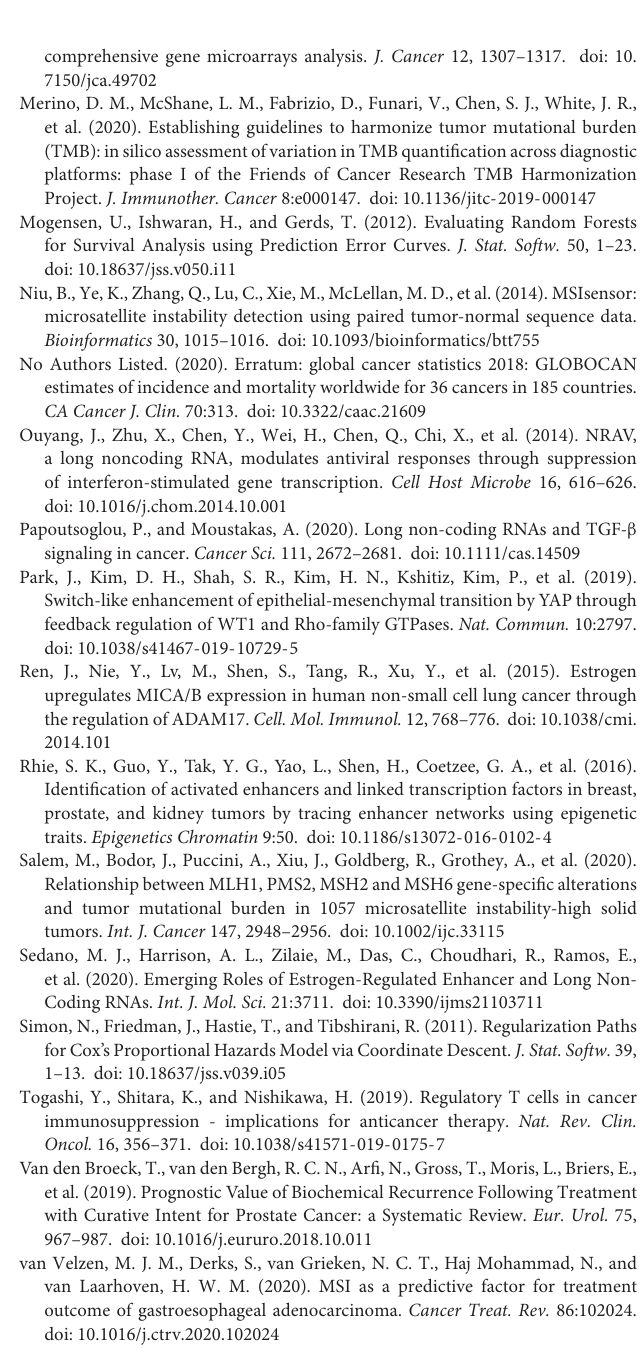
Supplementary Figure 6 | The rows and columns indicate the genes and tumor samples, respectively. Enrichment plots of the top five KEGG pathways in the high-risk score (A) and low-risk score (B) groups in PRAD. GO analysis of differential expression genes in high-low risk group (C) . Supplementary Figure 7 | Analysis of the difference of immune infiltration between the two algorithms of epic (A) and xcell (B) in the high- and low-risk groups. Supplementary Table 1 | In 1,000 iterations, eRNAs and target genes appeared more than or equal to 700 times.